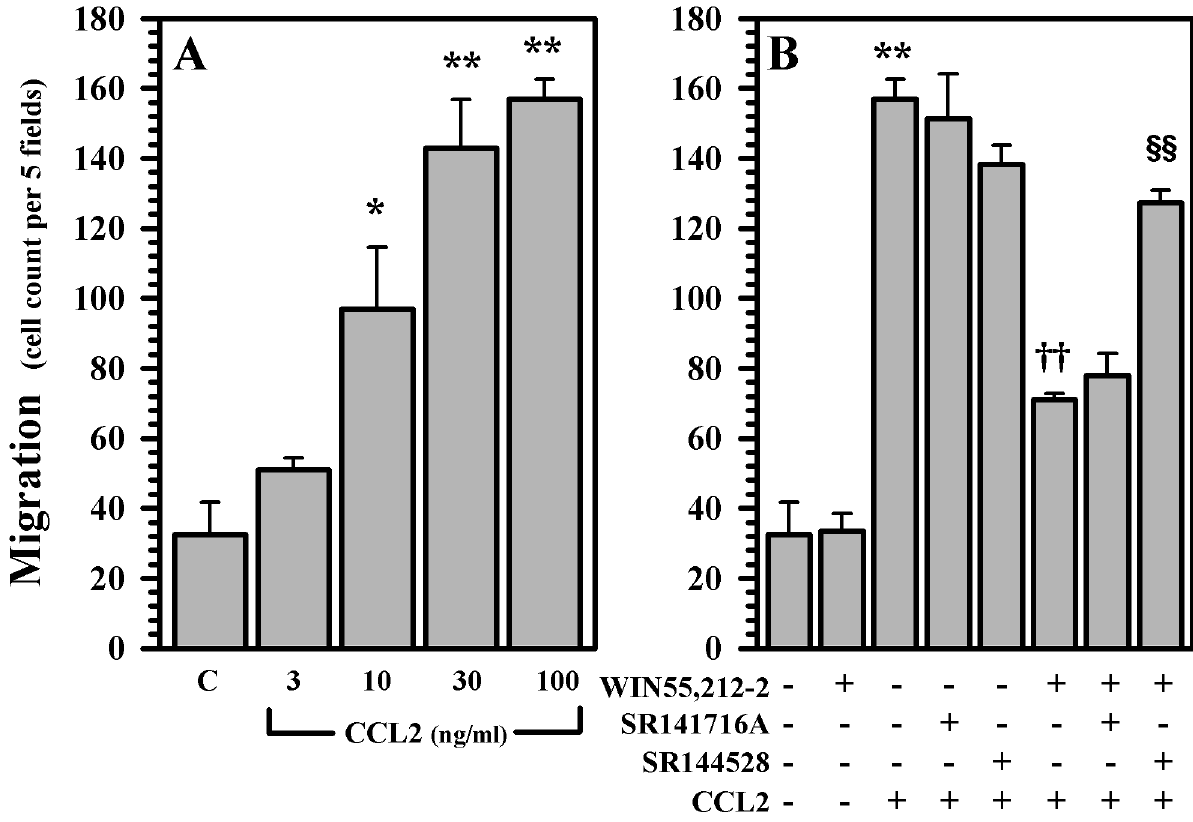
Figure 12. CB receptor-mediated microglial migration. A) Human microglia were loaded onto the upper chemotaxis chambers 2 with lower chambers filled with media (C) or CCL2 (3 to 100 ng/ml) and incubated for 3h. B) Human microglia were loaded onto upper chemotaxis chambers and pretreated with CB antagonists (SR141716A or SR144528, 3 µM) for 30 min followed by WIN55,212-2 (1 µM) treatment for 3h prior to be assembled with lower chambers filled with media (C) or CCL2 (100 ng/ml) and incubated for 3h. Migrated microglial cells were quantified by Diff-Quik staining. *p<0.05, **p<0.01 vs. control (C); †† p<0.01 vs. CCL2; §§ p<0.01 vs. WIN55,212-2+CCL2.